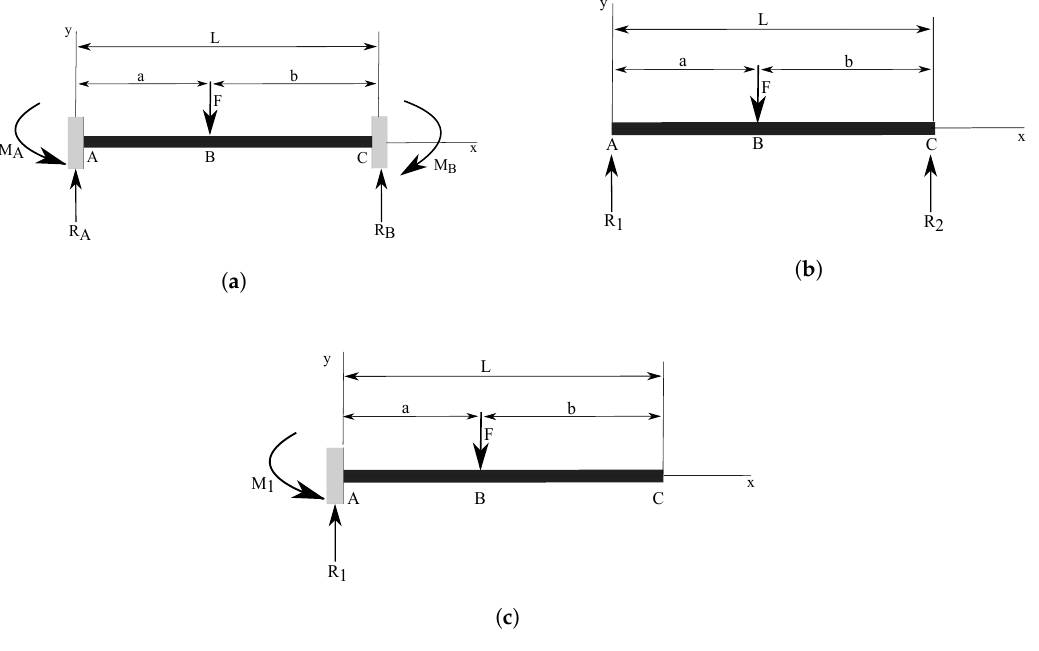
Figure 4. Beam configurations considered for the sensor design. ( a ) Fixed-Fixed beam structure with a concentrated load; ( b ) Simply supported beam structure with a concentrated load; ( c ) Cantilever beam structure with a concentrated